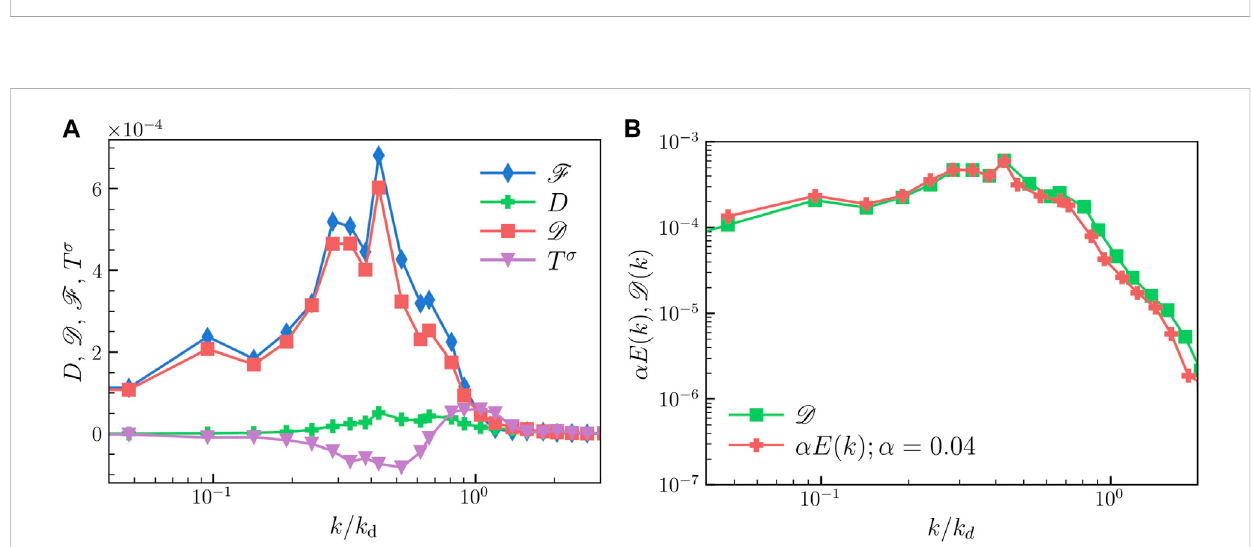
FIGURE 5 (A) Lin-log plot of the different contributions to the spectral energy budget (4) obtained from run H1 . (B) Log-log plot showing comparison of the scaled energy spectrum α E ( k ) and the dissipation due to drag D (k) for k / k d <